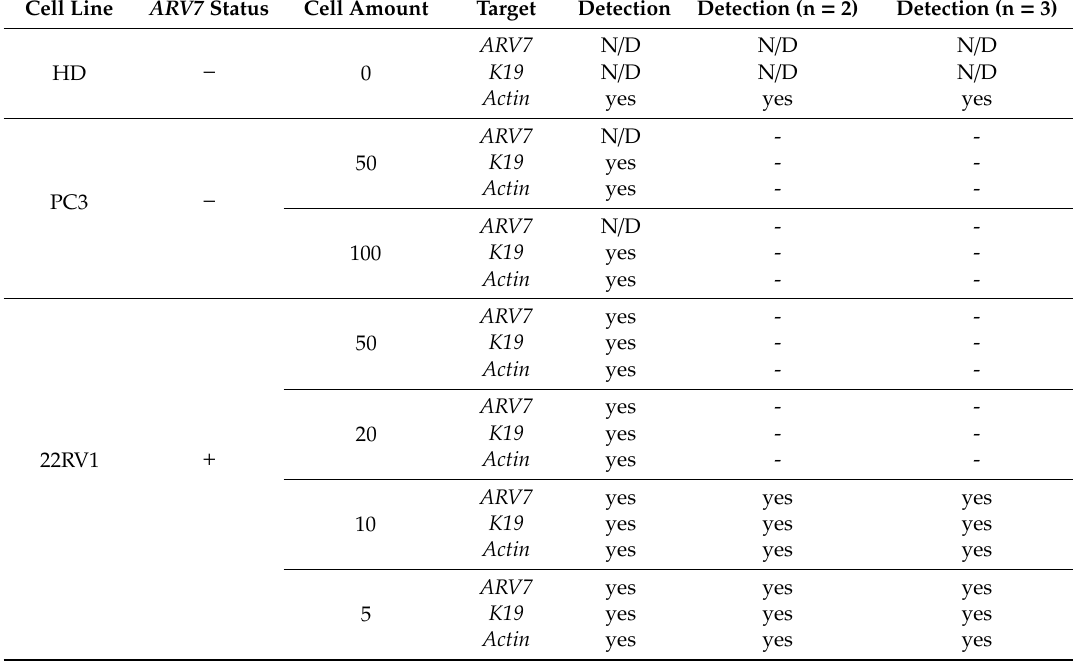
Table 1. Validation of protocol specificity and sensitivity. Titration experiments of spiked cell lines in blood from healthy donor (HD) samples. Indicated cell counts of ARV7 + (22Rv1) and ARV7 − (PC3) cells were manually spiked into HD blood and processed by our protocol. ARV7 status is highlighted as “ + ” for positive and “ − “ for negative samples. Detection of gene expression was confirmed when at least 2 / 3 triplicates were positive in qPCR analysis. Unamplified qPCR samples are marked as N / D (not detected). HD samples were processed in parallel as a negative control for ARV7 and K19 . The bar (-) in the respective table column of detection indicates no further experiments were